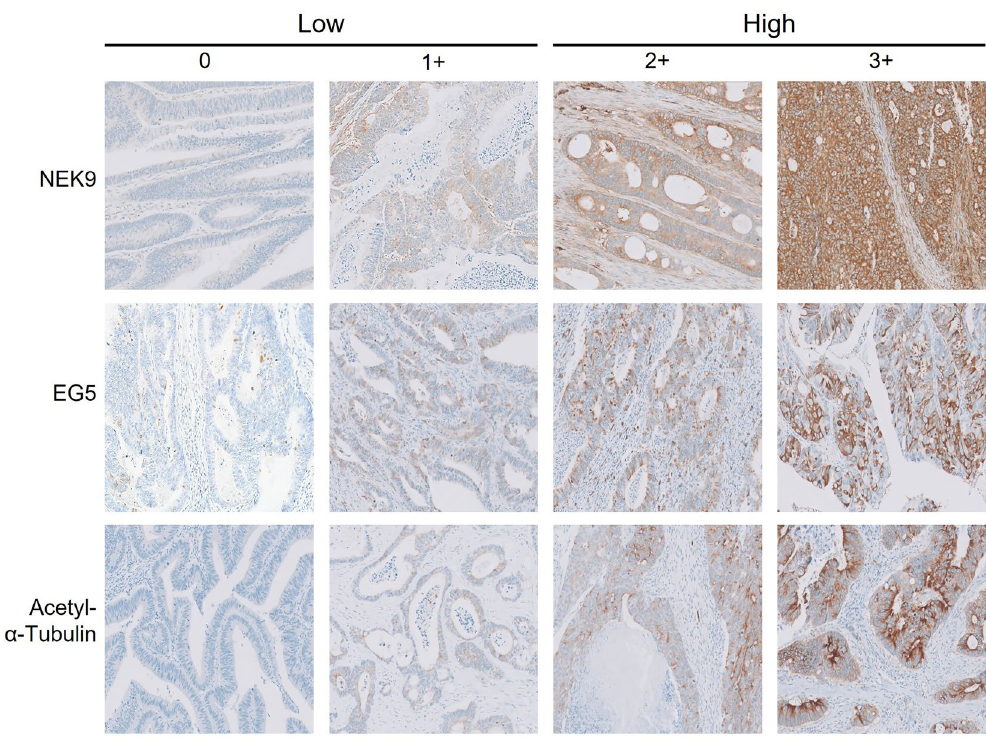
Figure 1. Representative images of immunostained tissue microarrays from the colon adenocarcinoma samples with immunoreactivity scores for NEK9, EG5, and acetyl-α-tubulin (magnification, × 200). NEK9, EG5, and acetyl-α-tubulin were thereby grouped into low- (score 0–1) or high- (score 2–3) expression